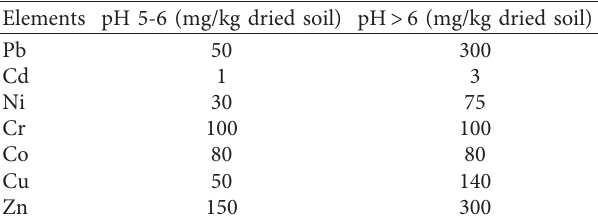
Table 4: Heavy metal limits in Turkey soil